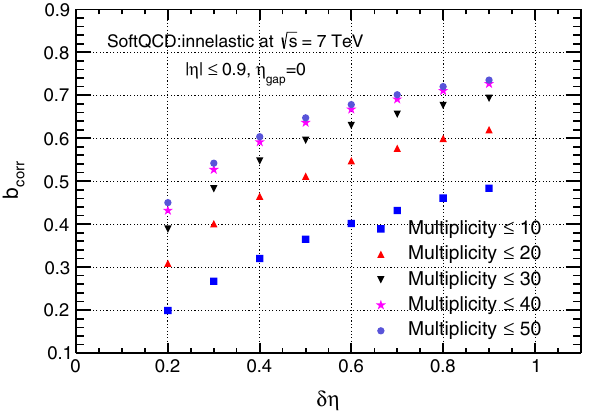
√ s = 7 TeV, for dif-